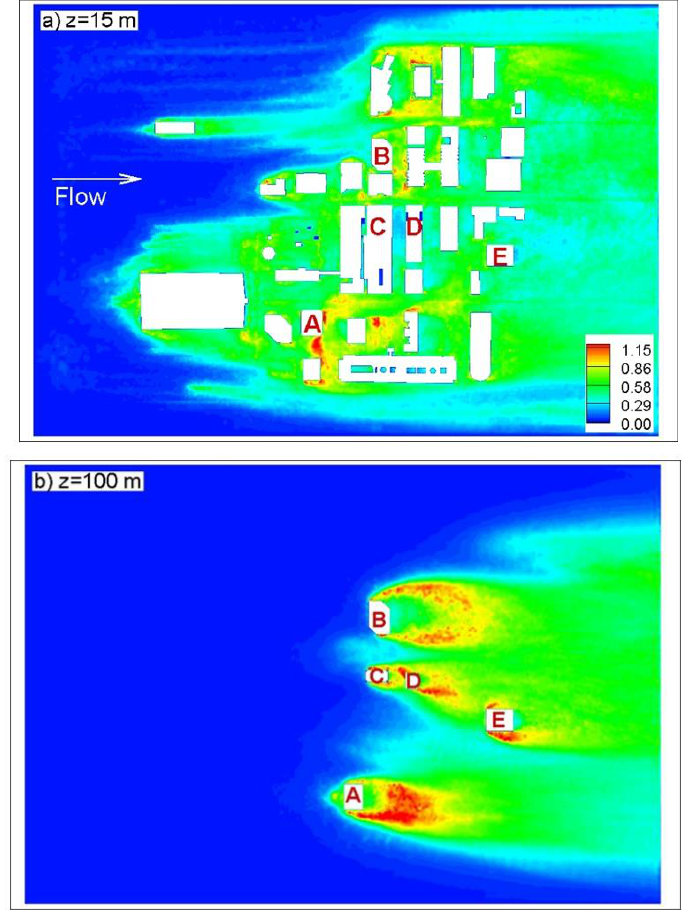
Figure 8. Turbulent intensity contours at ( a ) z = 15 m; ( b ) z = 100 m planes (see the location of planes in Figure 2).